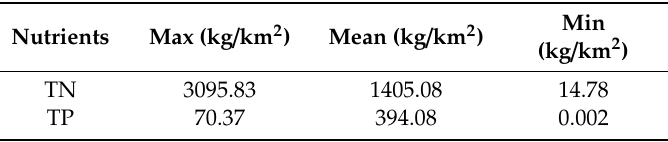
Table 4. Statistic of TN and TP output in